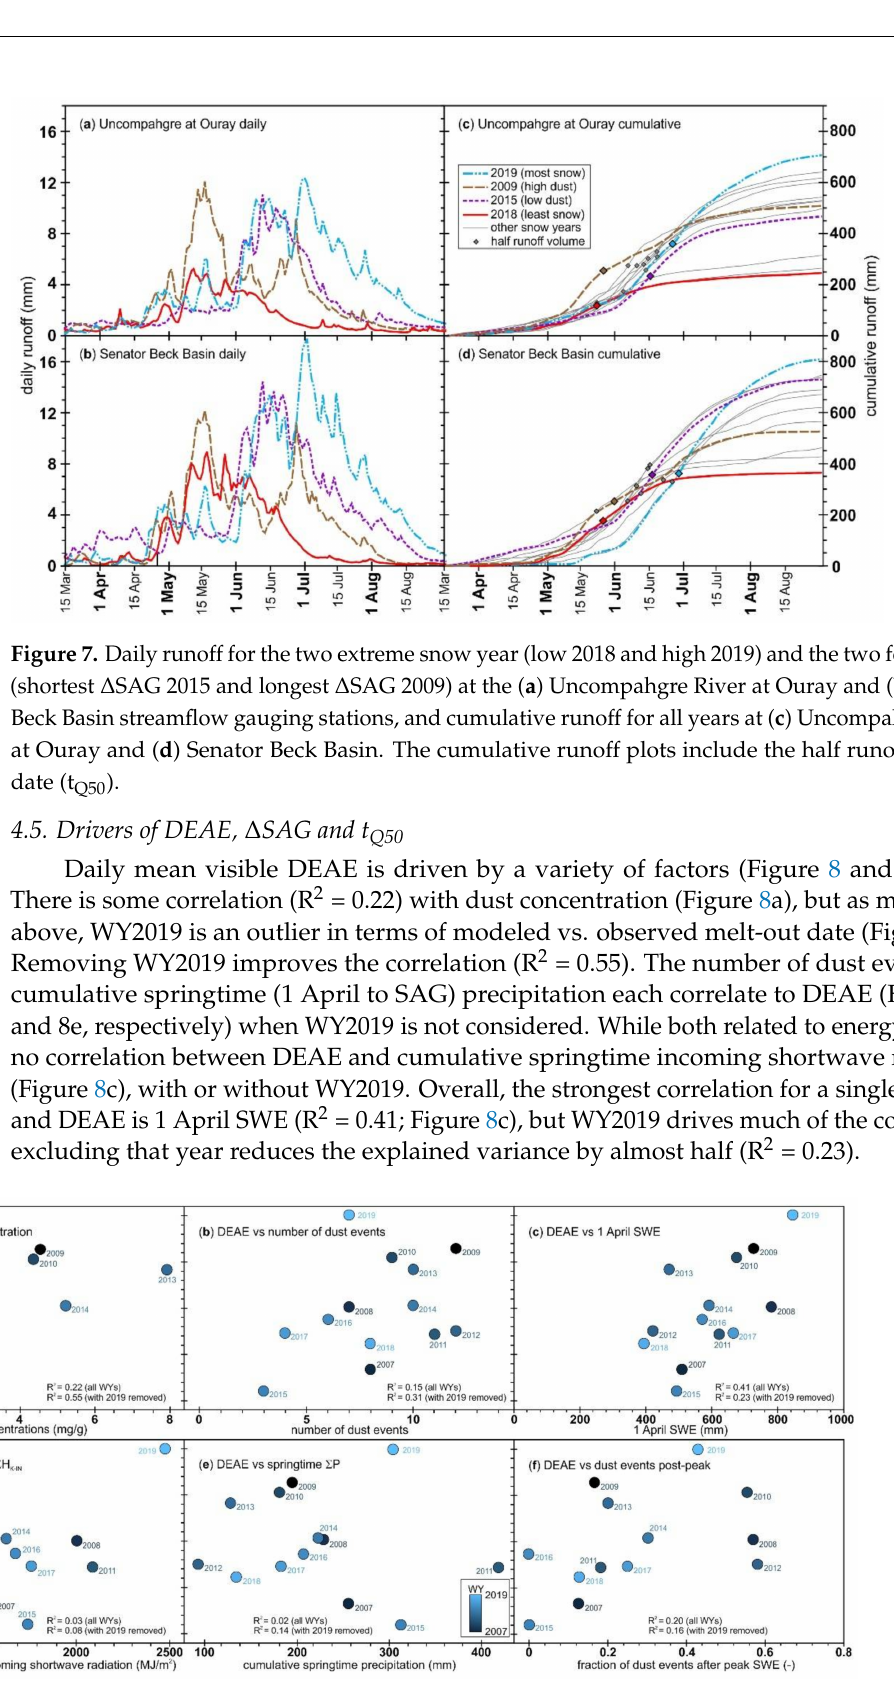
Figure 8. Comparison of daily mean visible dust-enhanced energy absorption (DEAE), as a function of ( a ) end-of-year dust concentration, ( b ) number of dust events, ( c ) 1 April SWE, ( d ) cumulative springtime (1 April to SAG) incoming shortwave radiation, ( e ) cumulative springtime (1 April to SAG) precipitation, and ( f ) the fraction of the dust events after peak